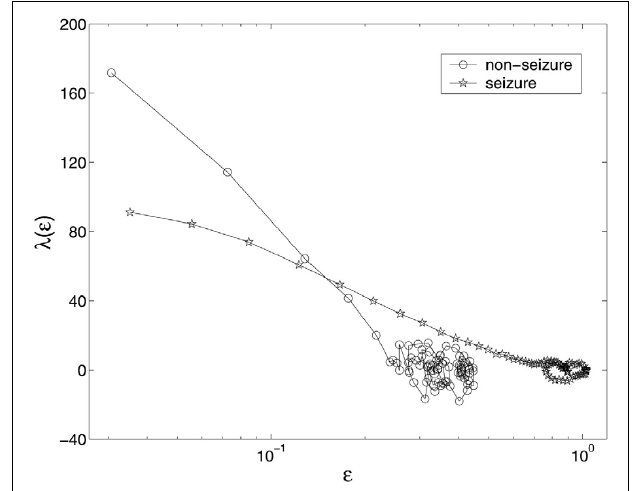
FIGURE 7 | Representative SDLE λ ( ε ) (per second) vs. ε for a seizure and non-seizure EEG segment.